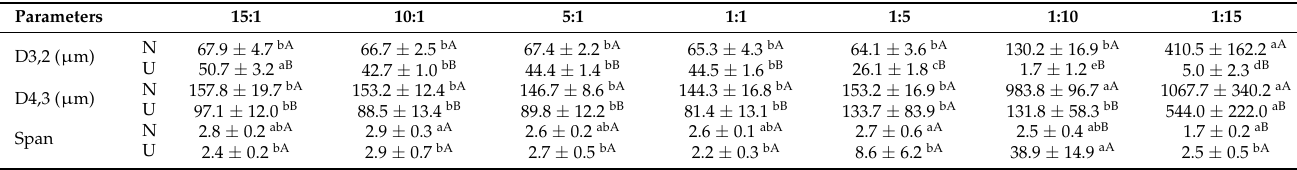
Different lowercase letters (a–e) in the same line and different uppercase letters (A and B) in the same column indicate significant difference ( p < 0.05) among